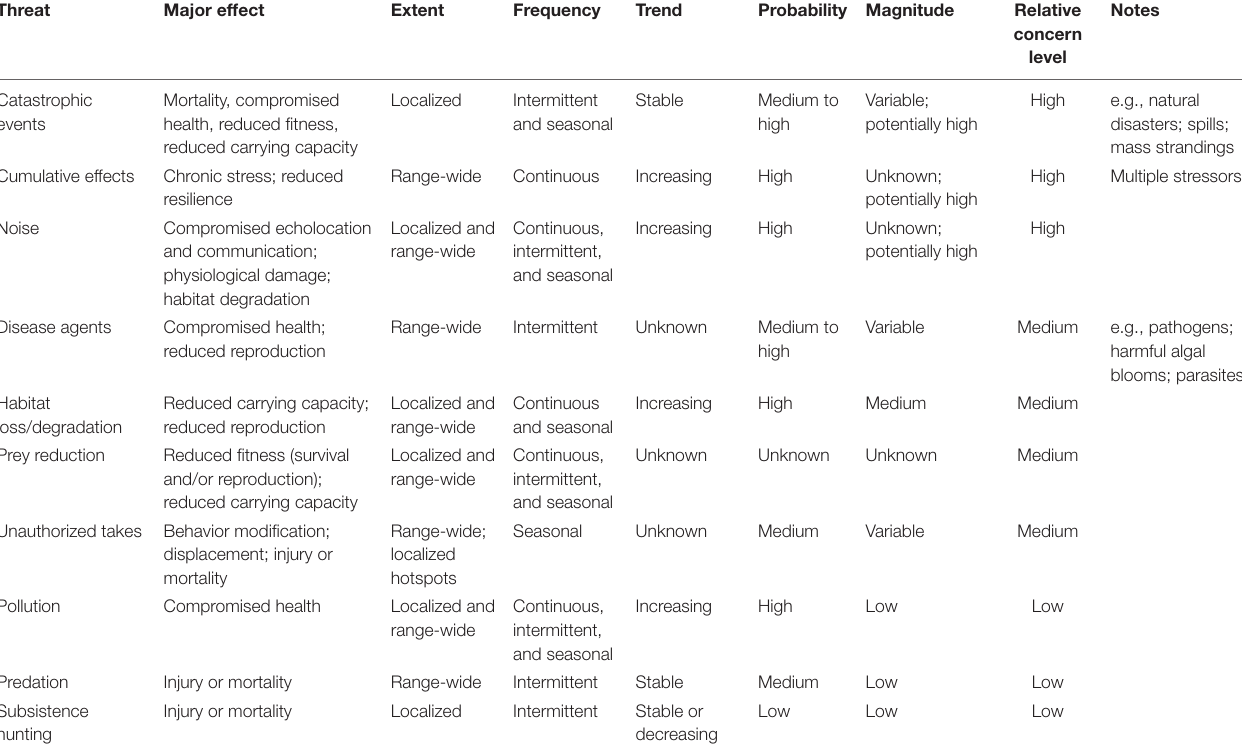
TABLE 1 | Potential threats to Cook Inlet belugas identified in their recovery plan (adapted from Table 6, NMFS,